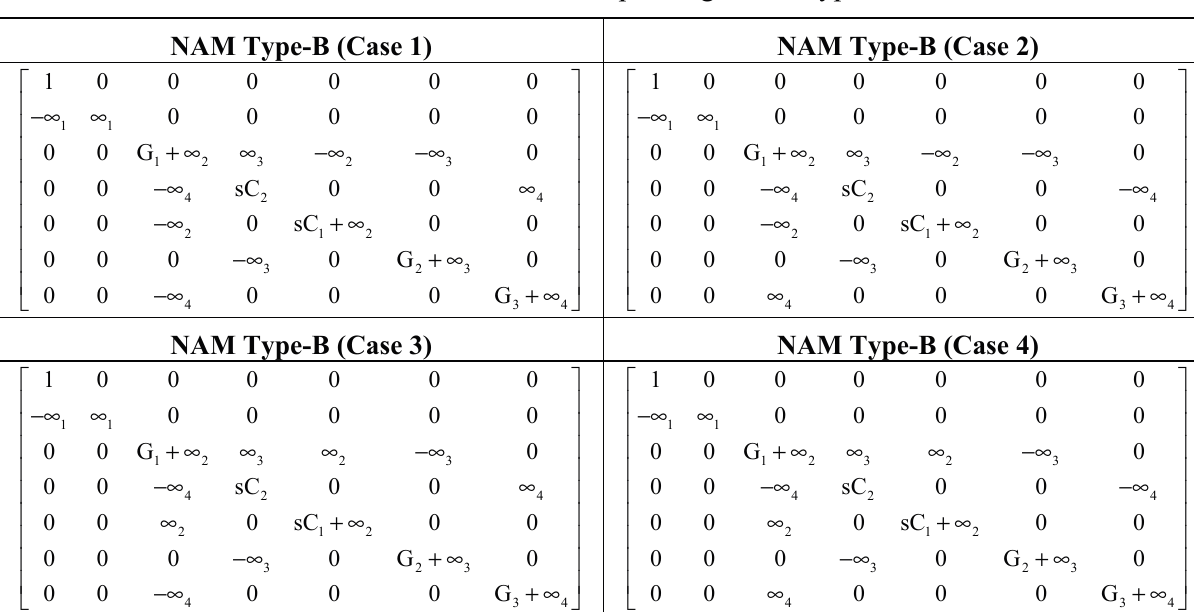
Table 2. Four cases of expanding NAM